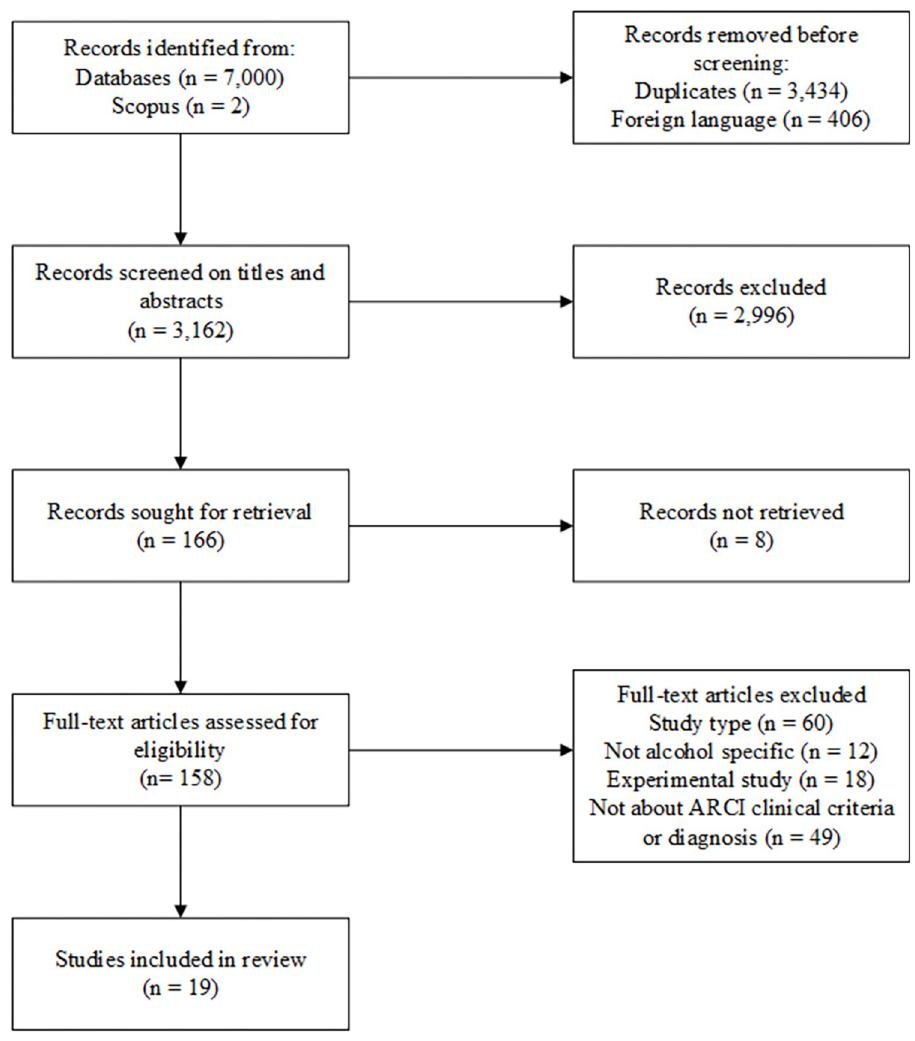
Fig 1. Study inclusion flow